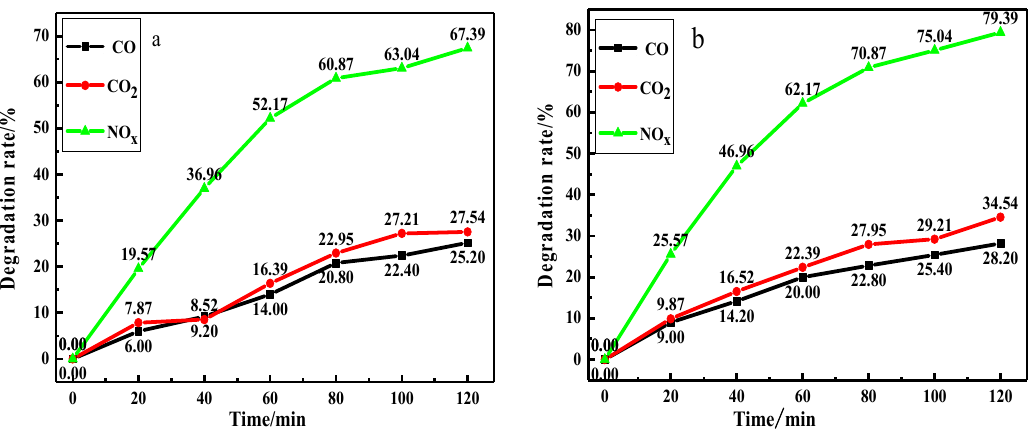
Figure 10. The degradation rate of VE under ( a ) visible light and ( b ) ultraviolet light.